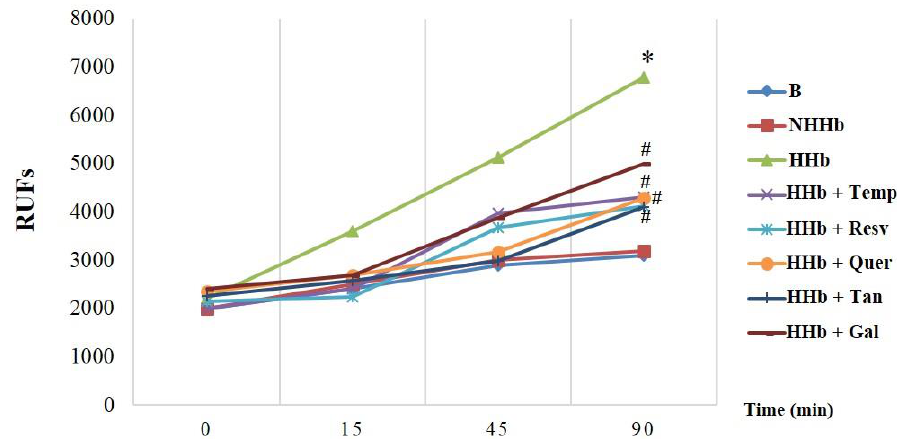
Figure 1. Polyphenols decrease reactive oxygen species induced by Amadori adducts. Representative experiments of the intracellular detection of superoxide anions over time using the fluorescence probe dihydroethidine (DHE). Human Peritoneal Mesothelial Cells (HPMCs) were treated with: HHb (10 nM); NHb (10 nM); HHb (10 nM) + resveratrol (Resv, 12.5 µ M); HHb (10 nM) + tannic acid (Tan, 10 µ M); HHb (10 nM) + quercetin (Quer, 10 µ M); HHb (10 nM) + gallic acid (Gal, 10 µ M); or HHb (10 nM) + Tempol (Temp, 100 µ M), a Reactive Oxygen Species (ROS) scavenger. For each experiment, 10 independent cultures of HPMCs were used, corresponding to 10 donors. Data represent the mean ± SD of at least seven independent experiments (for each culture of HPMCs corresponding to each of the 10 donors) expressed as relative fluorescence units (RFUs). * p ≤ 0.05 vs. basal. # p ≤ 0.05 vs. HHb.